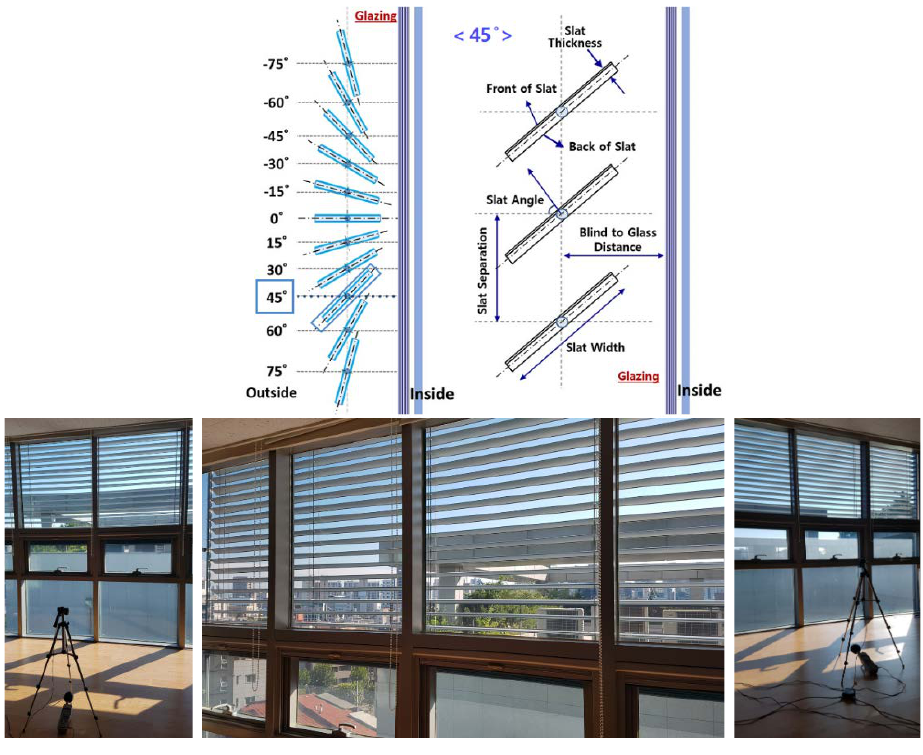
Figure 7. Blind diagrams and on-site installation images [40].